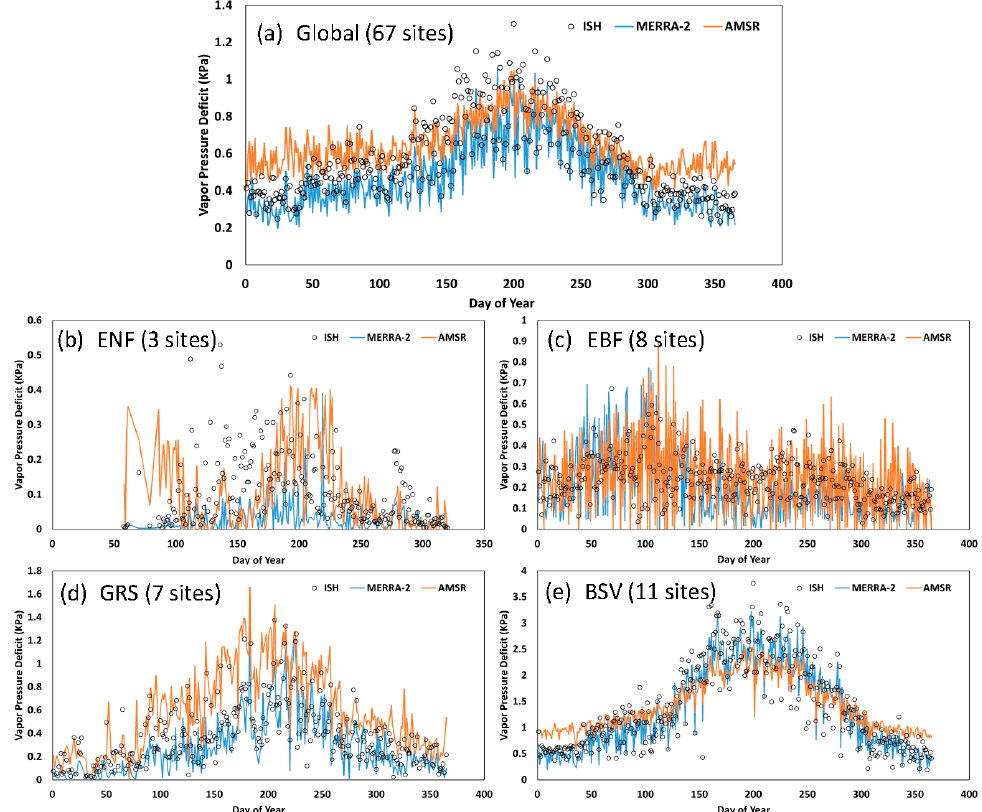
Figure 5. Morning (~1:30 a.m. local time) site-averaged Vapor Pressure Deficit (VPD) time series